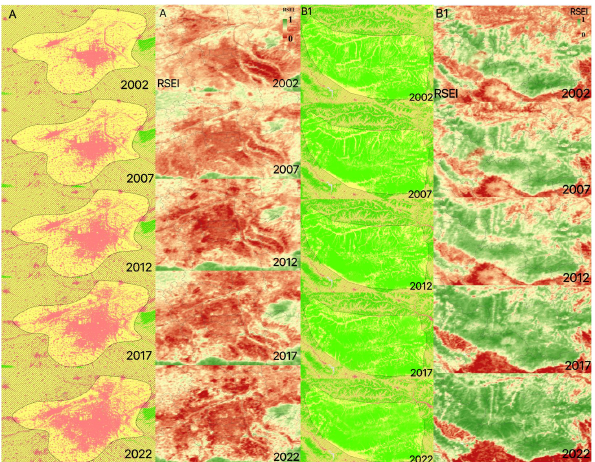
Figure 12. Local land use type and RSEI change in A (urban region) and B1 (part of GGP region) from 2002 to